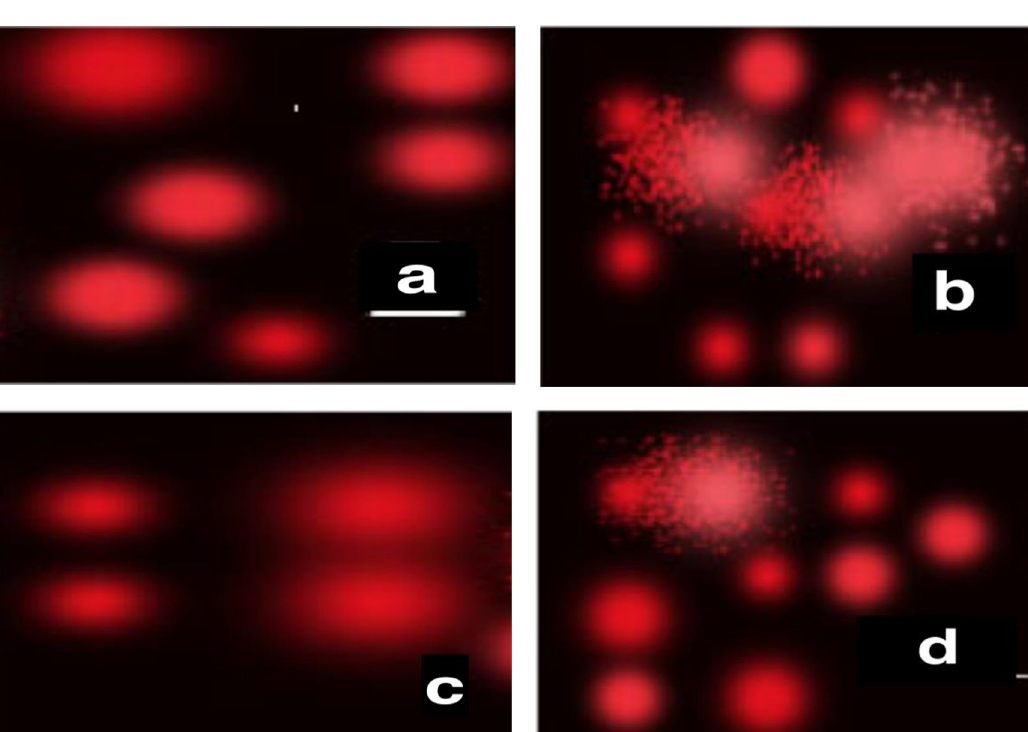
Fig 5. Comet assay for assessment of DNA damage in brain tissues of all studied groups. a, b, c, and d referred to control, Cr- intoxicated, SA, and Cr+SA groups, respectively.